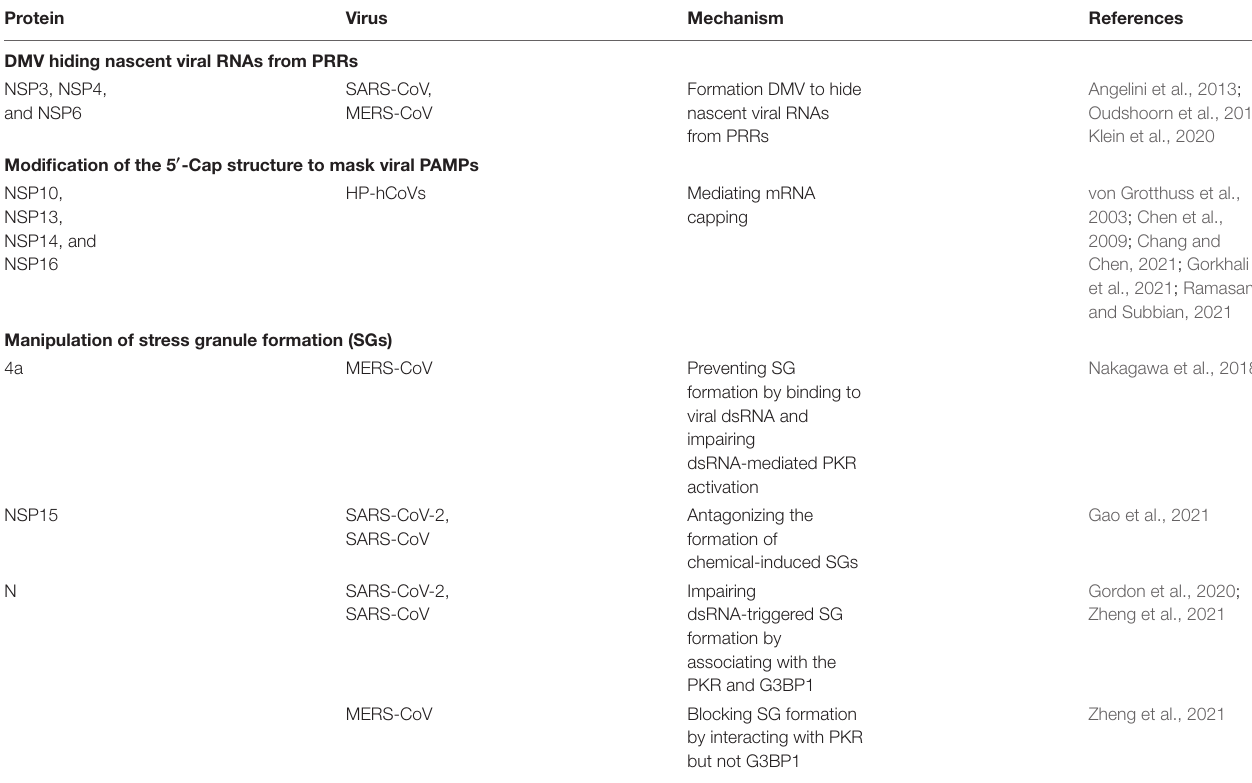
TABLE 1 | Strategies of highly pathogenic human coronaviruses (HP-hCoVs) to shield viral RNA from recognition by pattern recognition receptors